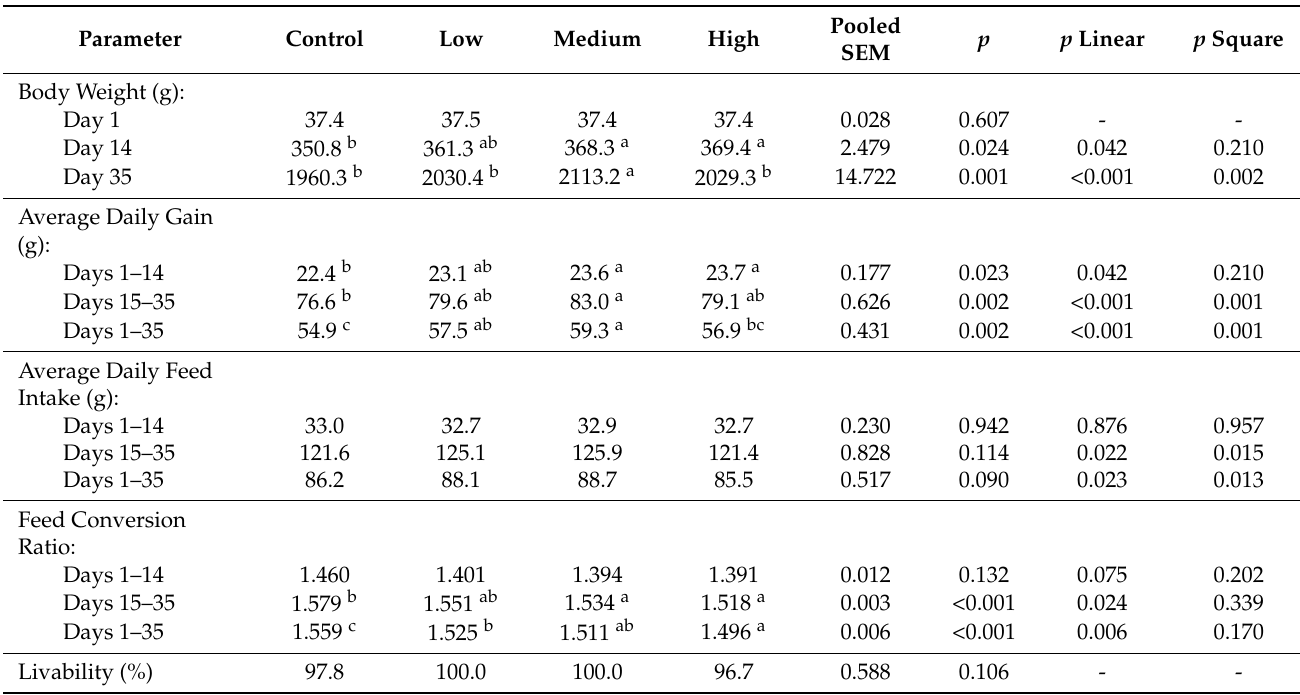
Table 3. Effect of different dosages of protected butyrate on broiler performance #